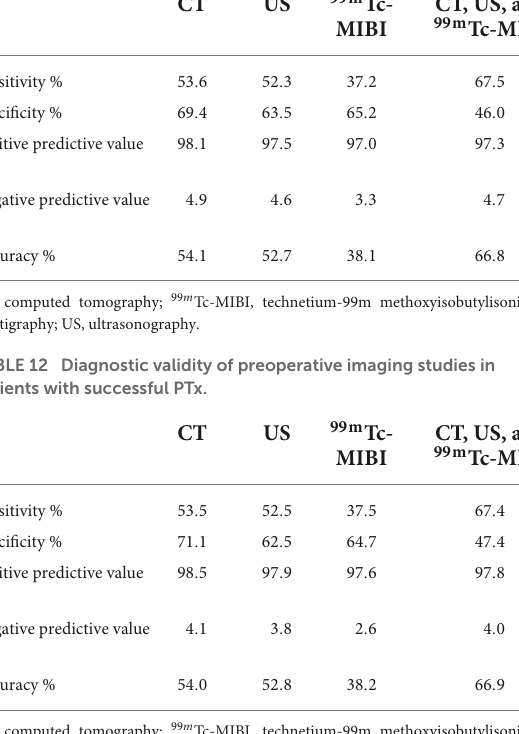
TABLE 10 Details of infranumerary parathyroid glands.